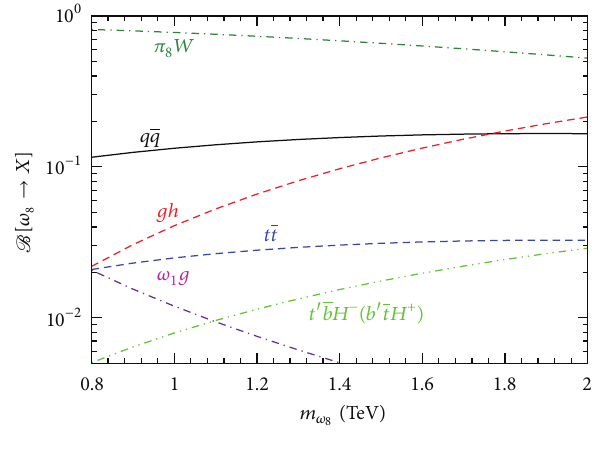
Figure 14: Branching ratios for 2HD model for the parameter choices of Case 4. Here we take 𝑚 ℎ = 125 GeV and 𝑚 𝐻 ± = 200 GeV.